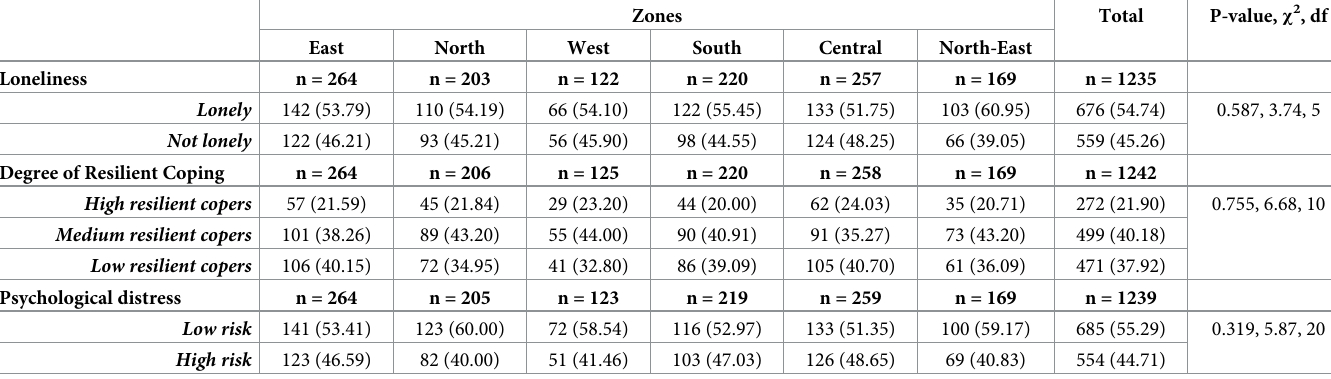
Table 4. Loneliness and resilient coping and psychological distress among the respondents.